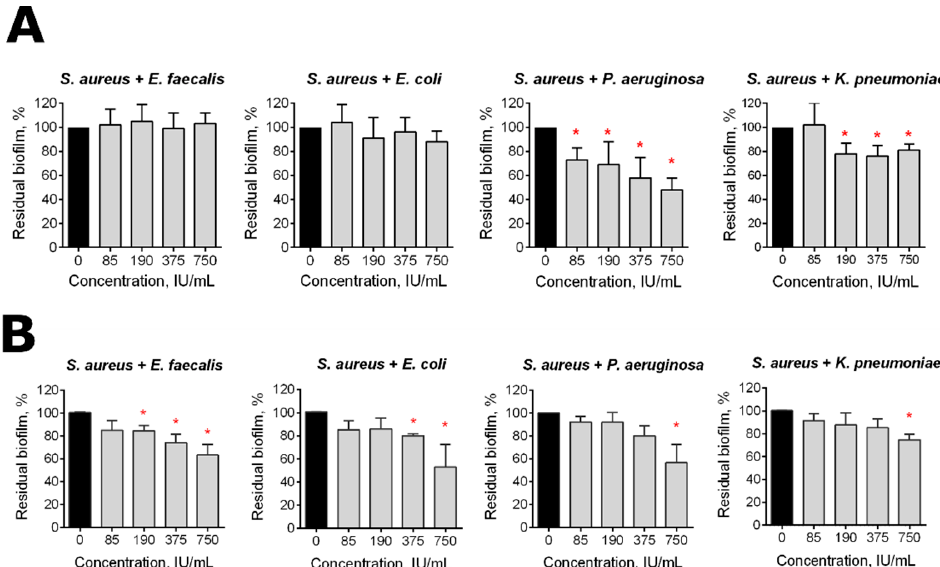
Figure 2. The effect of Longidaza ® on mixed bacterial biofilms. The 48-h old biofilms were gently washed with BM broth, and a fresh BM broth containing Longidaza ® at concentrations of 85–750 IU/mL was loaded. After either 4 ( A ) or 24 ( B ) hours of treatment, the residual biofilms were quantified by crystal violet staining. The asterisks (*) denote statistically a significant difference of the biofilm in the untreated wells and wells treated with Longidaza ® ( p < 0.05).